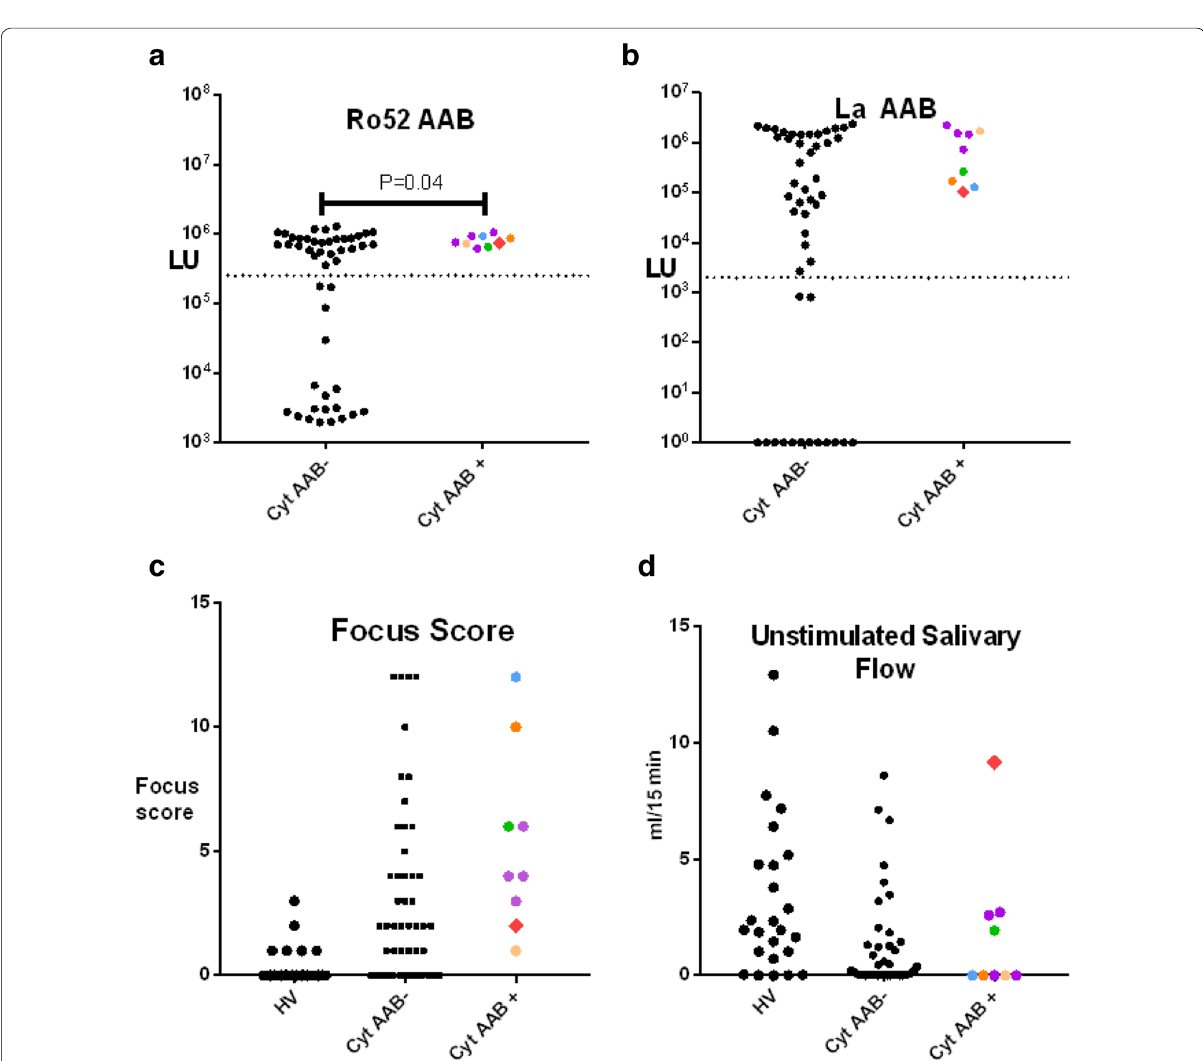
Fig. 3 Clinical correlates of cytokine autoantibodies in SS. The SS cohort was stratified based on the 48 SS subjects with cytokine autoantibody seronegative status (Cyt AAB ), or 9 SS subjects with cytokine autoantibody seropositive status (Cyt AAB ). The color coding of the cytokine − + seropositive samples corresponds to their display in Fig. 1. The SS subject (#56) with partially neutralizing autoantibodies to interferon-α is shown by the red diamond. a Ro52 and b La autoantibodies were measured by LIPS and analyzed. The dotted line is based on cut-off value from HV. Mann– Whitney U test was used for statistical analysis. c The focus score, a histological marker assessment of the amounts of inflammatory cells in the salivary gland biopsy and d unstimulated salivary flow for the subjects is shown for the HV, Cyt AAB and Cyt AAB −